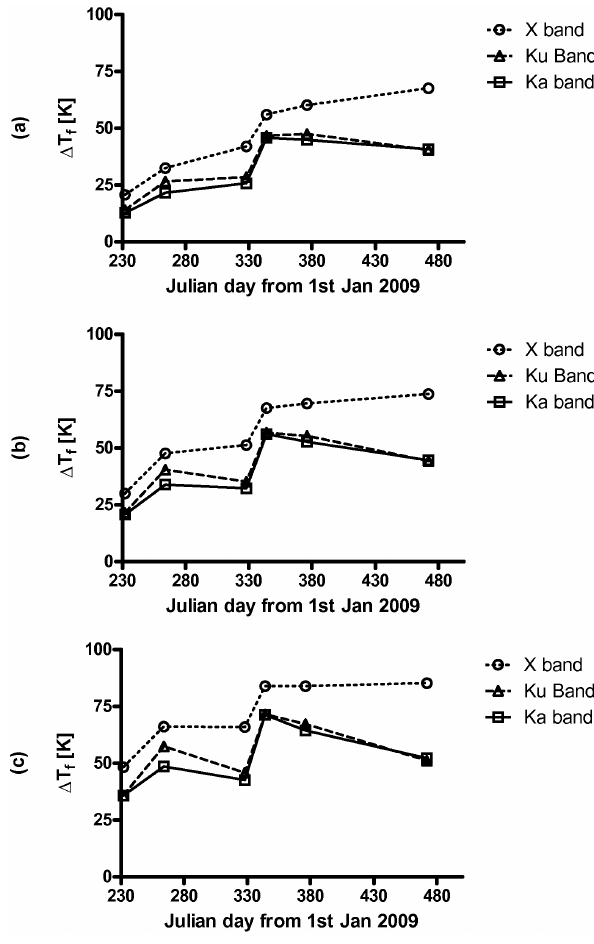
Fig. 9. Polarization differences as a function of time for the three AMSR-E considered bands. (a): Overall measured ∆ T obs (b): con- tinent ∆ T c . (c): wetland ∆ T wet .